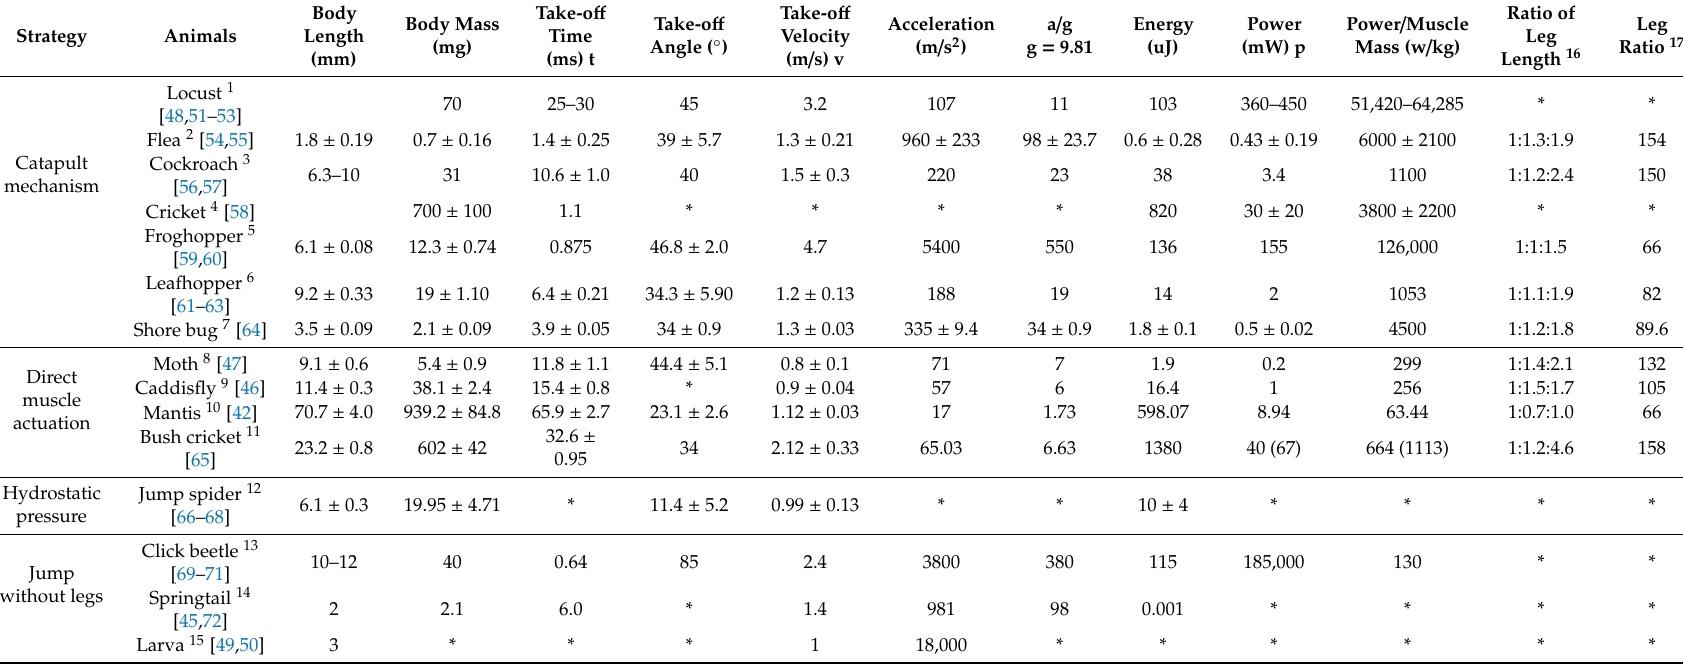
Table 1. Comparisons of tested jumping performance in invertebrate